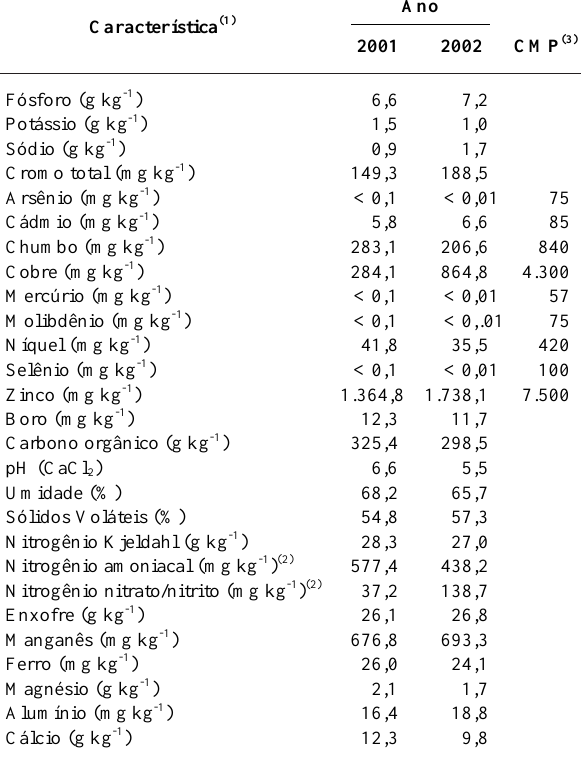
(1) Os valores de concentração (total) são dados com base na ma- téria seca. (2) Os valores de concentração para o N na forma amoniacal e de nitrato foram determinados na amostra nas con- dições originais. (3) CMP (Concentração Máxima Permitida) P 4230, CETESB